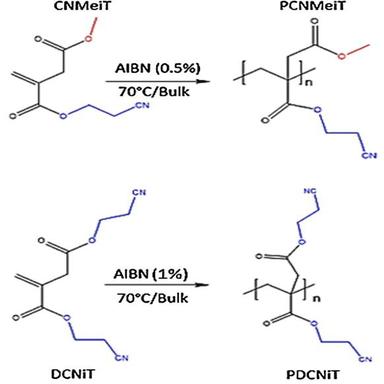
FTIR spectra of both poly(itaconate)s.